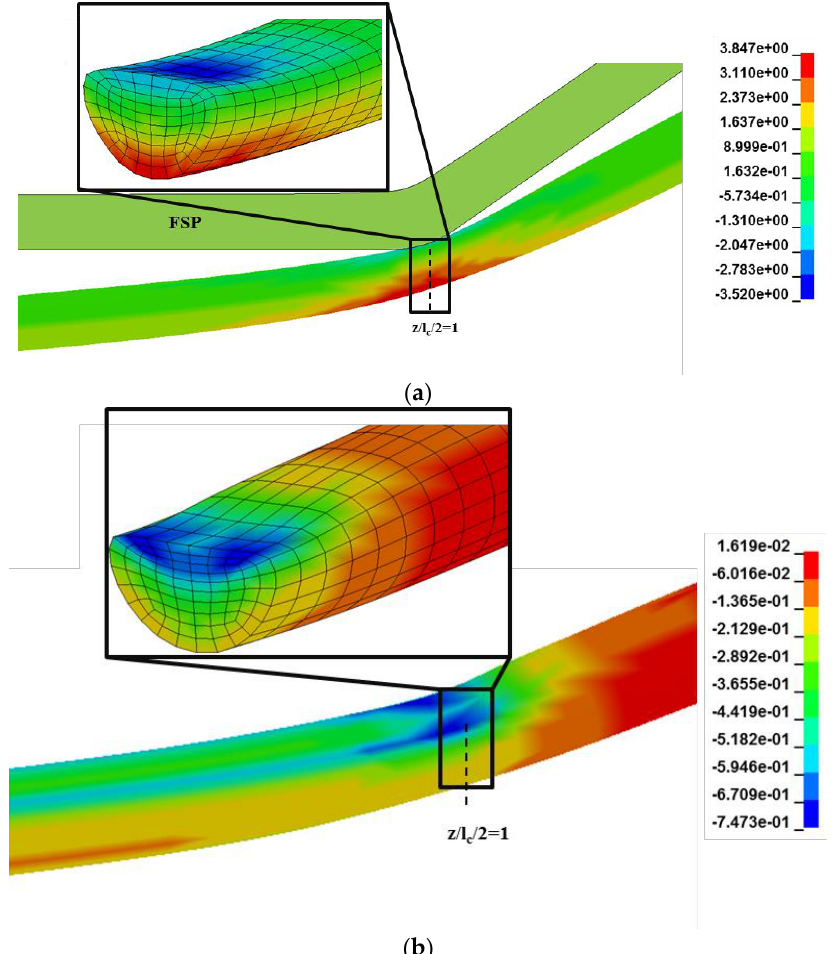
Figure 8. FSP impact at 300 m/s, inelastic fiber behavior: ( a ) contours of axial stresses in GPa at 0.50 µs; and ( b ) transverse compressive strains at 0.05 µs.